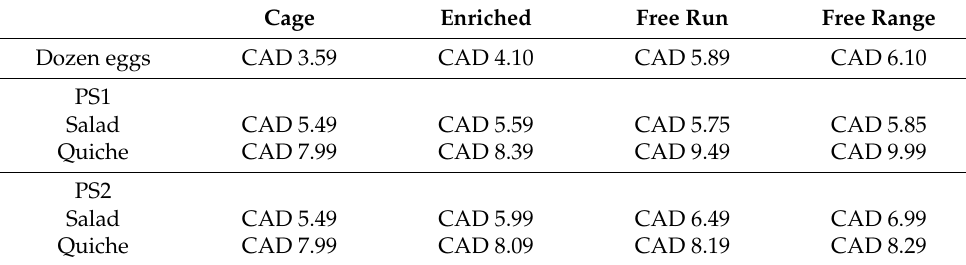
Table 1. Price by type of eggs by price treatment.